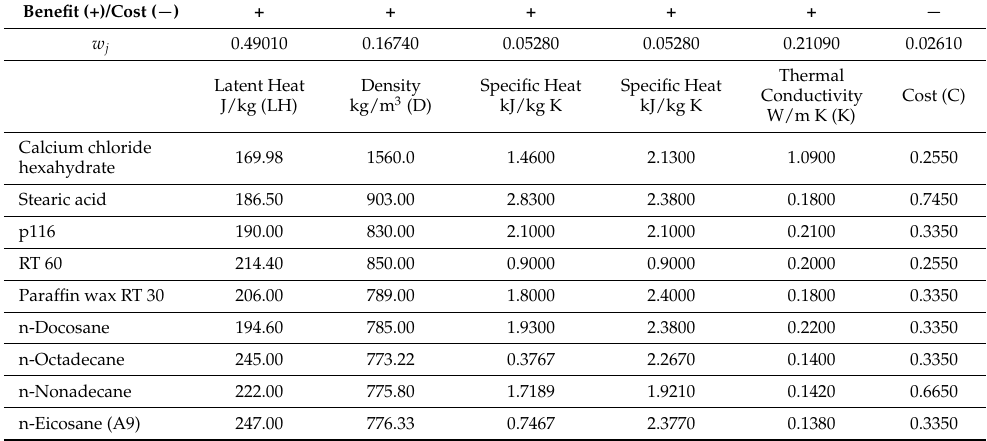
Table 1. Material selection decision matrix.